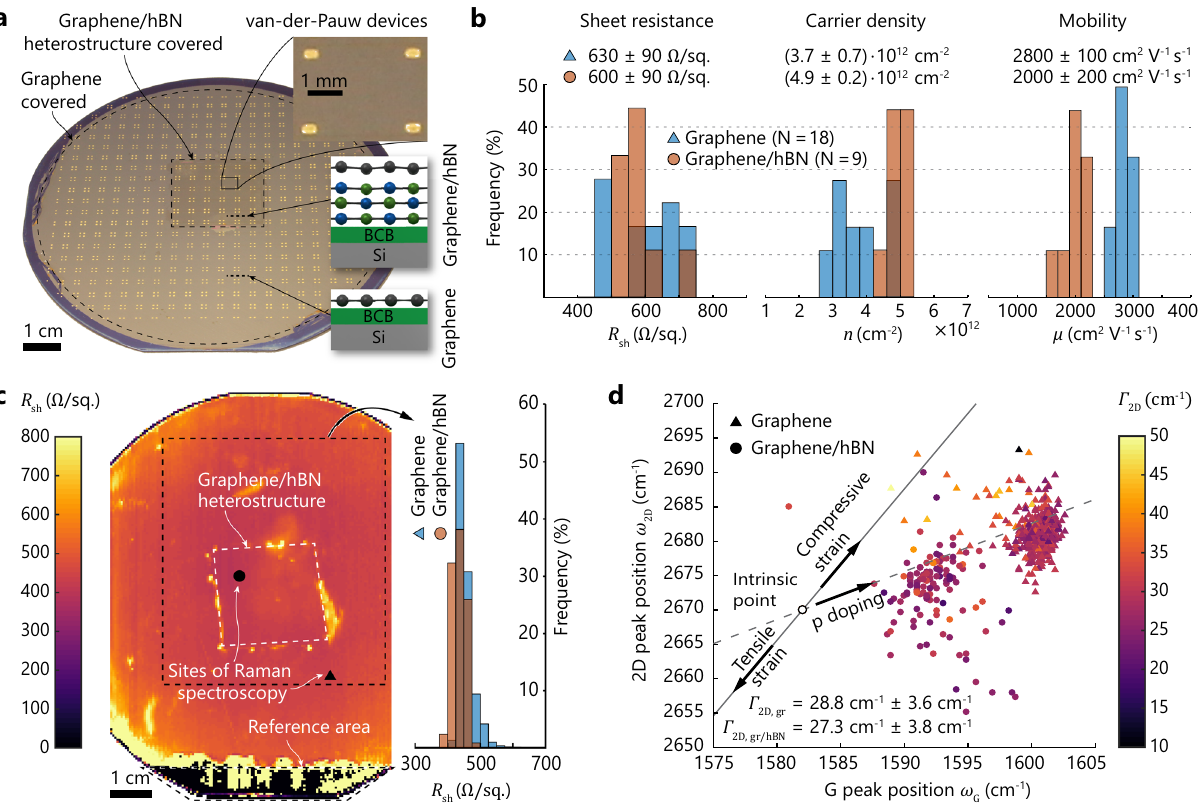
Fig. 2 Characterization of transferred CVD graphene and graphene/hexagonal boron nitride (hBN) heterostructures. a Photograph of a 100-mm- diameter silicon wafer with van der Pauw (vdP) devices. The graphene sheet covers the entire wafer and lies on top of multilayer CVD hBN in the marked region. b Extracted sheet resistance ( R sh ), carrier density ( n ), and charge carrier mobility ( μ ) from Hall measurements of vdP devices at room temperature (number of devices: 18 graphene (blue); 9 graphene/hBN (red)). c Spatially resolved map of R sh extracted from noncontact terahertz near- fi eld spectroscopy, indicating a uniform coverage of graphene on the entire high resistive silicon wafer (average within the marked region: 450 ± 50 Ω sq (cid:1) 1 ). d Correlation map of the Raman G and 2D peak position ( ω G and ω 2D , respectively) of the transferred graphene (triangles) and the graphene/hBN heterostructure (circles). The colormap represents the extracted full-width at half-maximum of the 2D peak ( Γ 2D ) of the transferred graphene ( Γ 2D,gr ) and the graphene/hBN heterostructure ( Γ 2D,gr/hBN ). The open circle indicates the peak positions of intrinsic graphene 74 . The total number of spectra for graphene on bisbenzocyclobutene (BCB) and graphene on hBN is 430 and 124, respectively. Note, a , b are from the same sample, whereas c , d are performed on a second